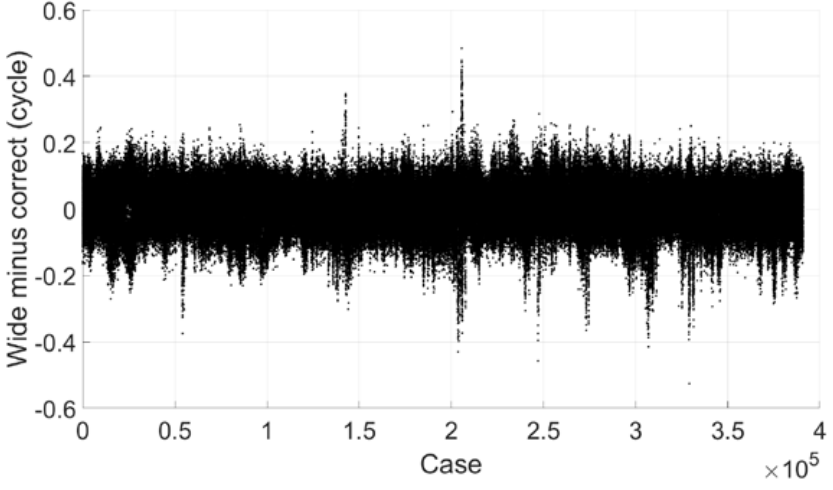
Figure 5. Wide-lane ambiguity minus correct integer ambiguity (BDS).